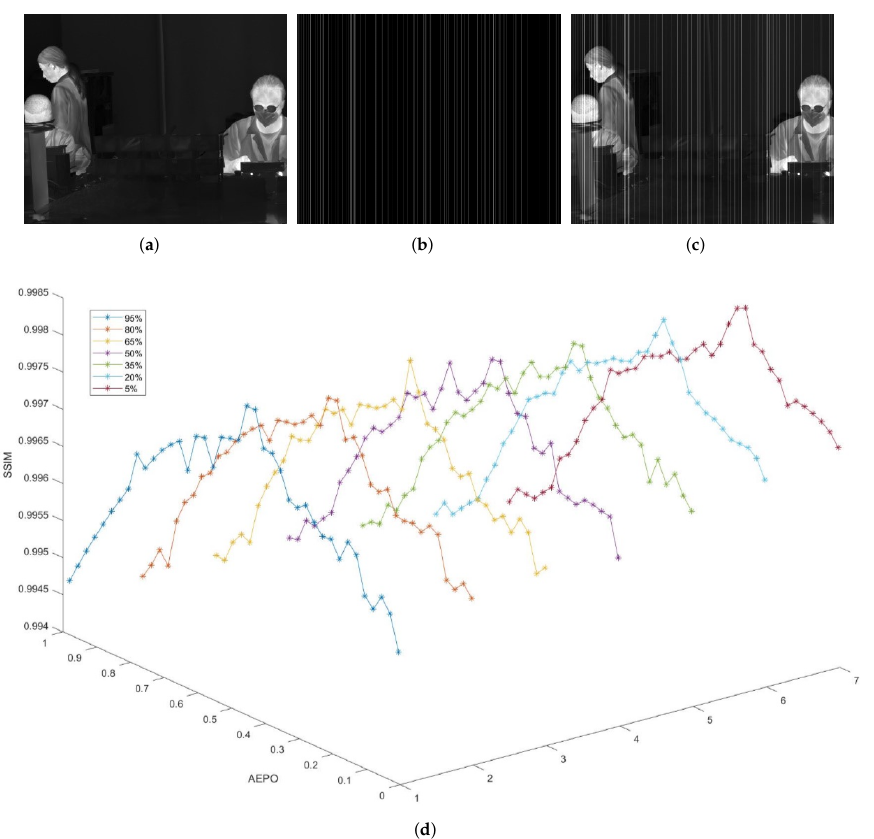
Figure 4. Experiments on the AEPO: ( a ) reference image; ( b ) noisy image; ( c ) test image; ( d ) correlation of SSIM with AEPO and edge contrast.